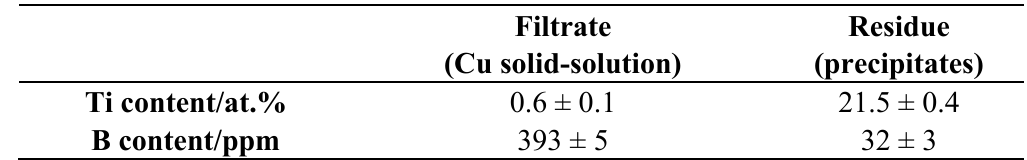
Table 1. Chemical composition of Cu solid-solution and precipitation phases in the Cu–4Ti–0.03B alloy that was aged at 450 °C for 480 h. The extraction method and inductively coupled plasma atomic emission spectrometry (ICP-AES) measurements were used to analyze the chemical composition.